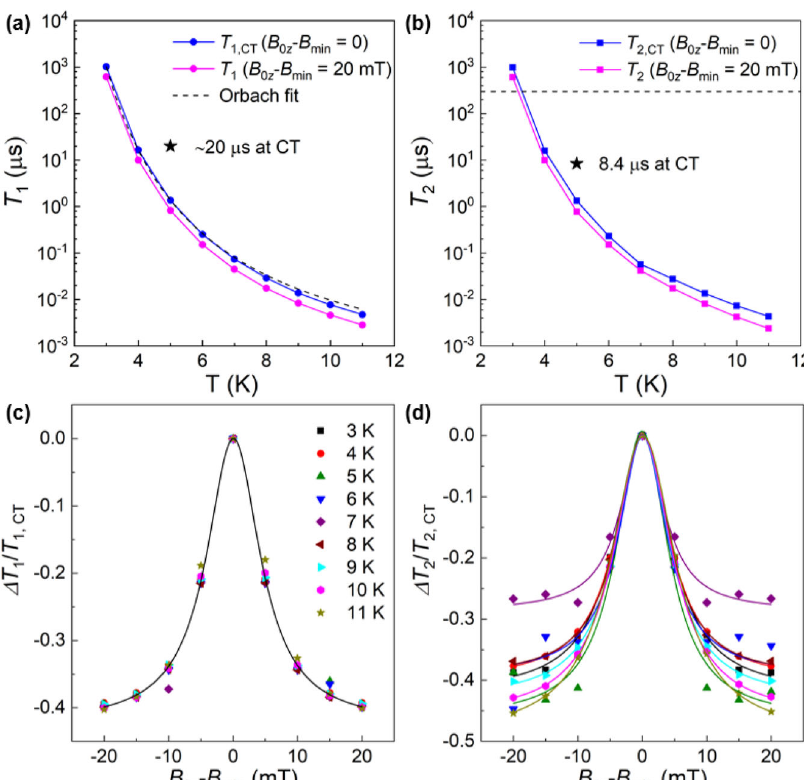
Fig. 2 Longitudinal and transverse relaxation times. a Calculated T 1 and b T 2 as a function of temperature at the CT and at 20 mT away from the CT. The dashed line in b indicates the T 2 limit of 300 μ s estimated from nuclear spin bath in ref. 22 . c T 1 and d T 2 divergences around the CT at different temperatures. The curves serve as a guide for the